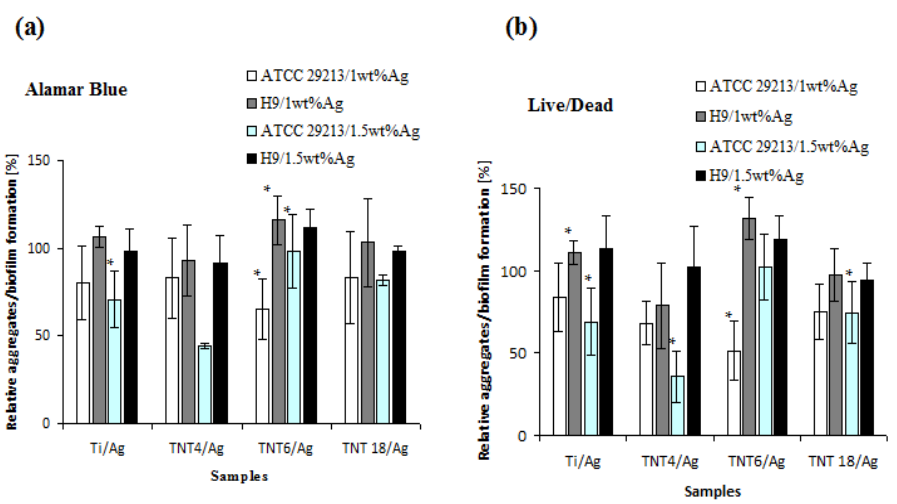
Figure 3. Staphylococcus aureus aggregates/biofilm formation on the surfaces of Ti/Ag and TNT/Ag coatings studied by ( a ) Alamar Blue staining and ( b ) Live/Dead BacLight Bacterial Viability kit. The results are presented as the mean percentage of metabolically active/live bacteria reclaimed after 24 h from Ti/Ag and TNT/Ag surfaces, compared to bacteria reclaimed from the conventional (unmodified) Ti surface (control considered as 100%). Asterisk indicates significant differences between tested and control surfaces (* p ≤ 0.05).